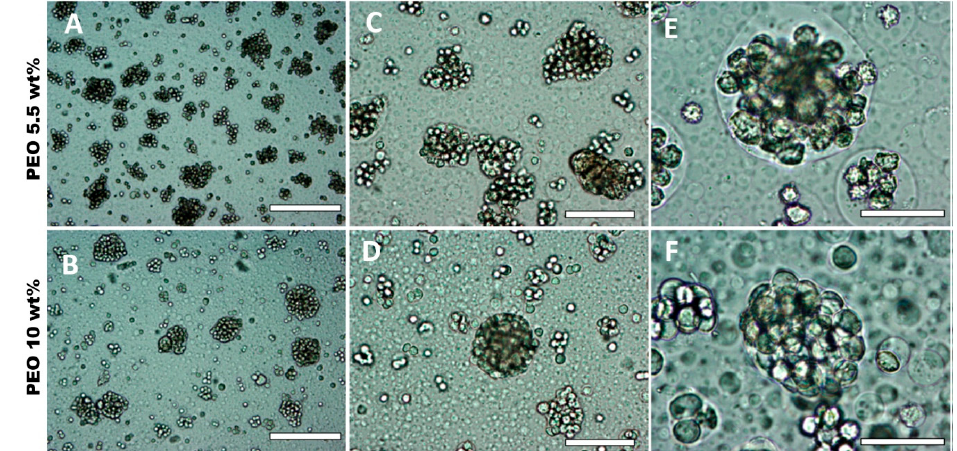
Figure 5. Optical microscopy images of ( A , C , E ) HaCaT cell droplets (5.5 wt% PEO/5.5 wt% Dextran) and ( B , D , F ) HaCaT cell clusteroids (10 wt% PEO/5.5 wt% Dextran) stabilized by 2 wt% WP particles. Here the cell and DEX volume fraction were, ф HaCaT = 0.15 and ф DEX = 0.25, respectively. Scale bars are ( A , B ) 200 µ m, ( C , D ) 100 µ m and ( E , F ) 50 µ m. Biomimetics 2019 , 4 , 50